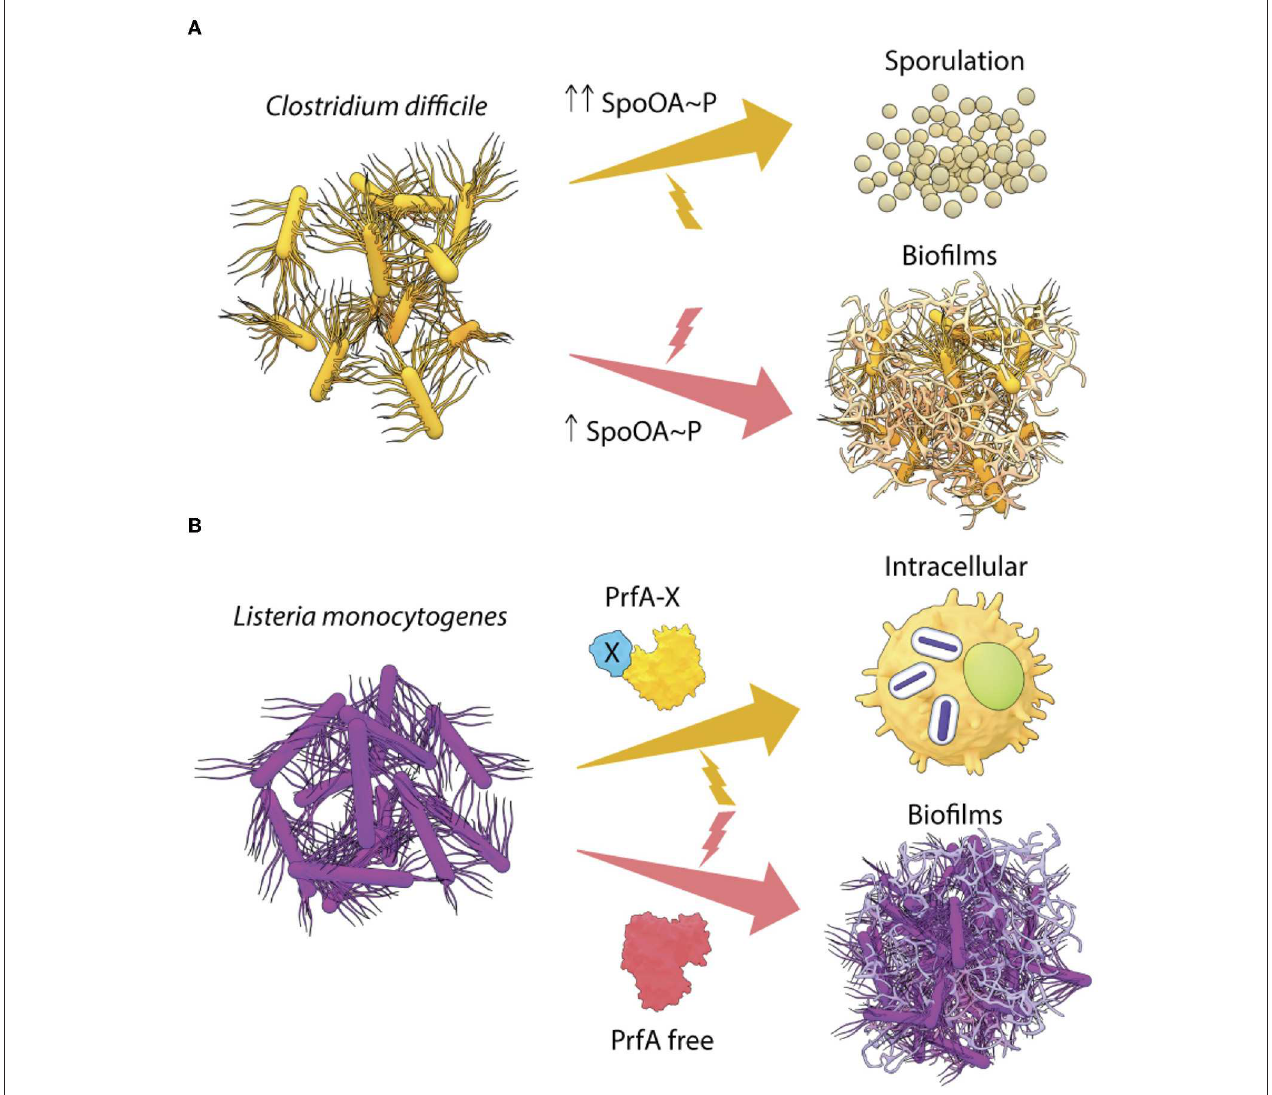
FIGURE 2 | Transcriptional regulators drive lifestyle changes in Gram-positive pathogens. (A) In C. difficile , the intracellular levels of Spo0A ∼ P regulate the lifestyle switch to form spores or biofilms and (B) two different forms of the transcriptional regulator PrfA in L. monocytogenes, are required to activate the intracellular lifestyle or to form in vivo